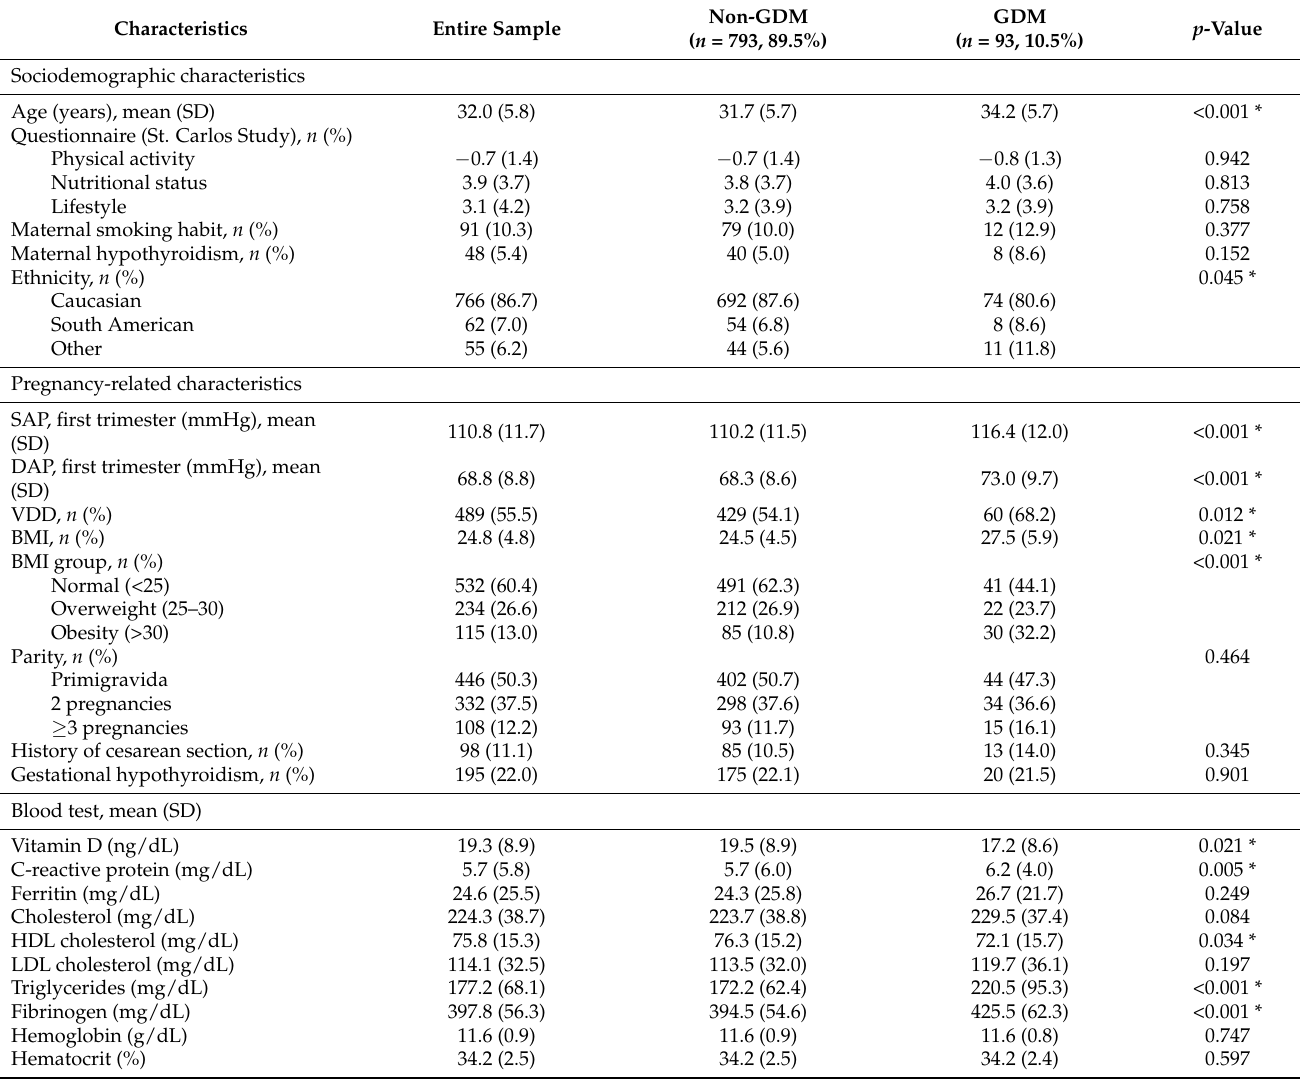
Table 1. Participants’ characteristics in relation to gestational diabetes mellitus